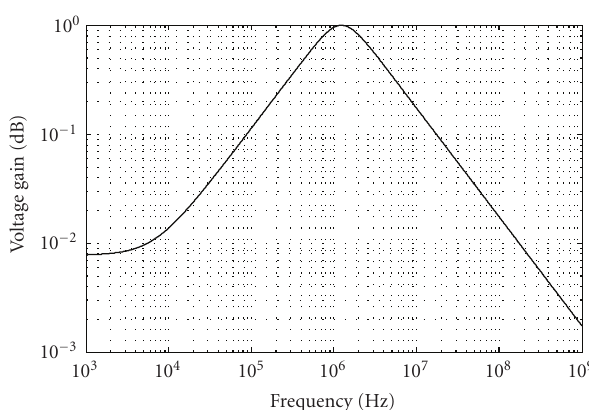
Figure 11: Frequency response of BPF using simulated grounded inductor.